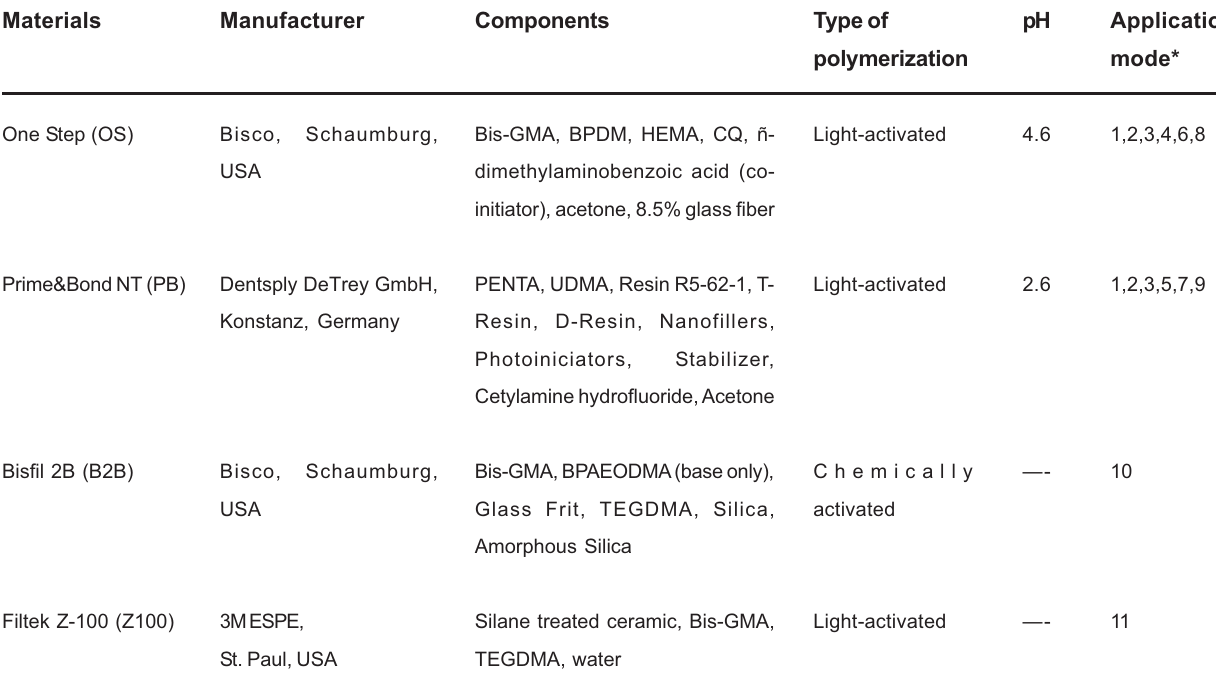
TABLE 1- Characteristics of adhesive systems and